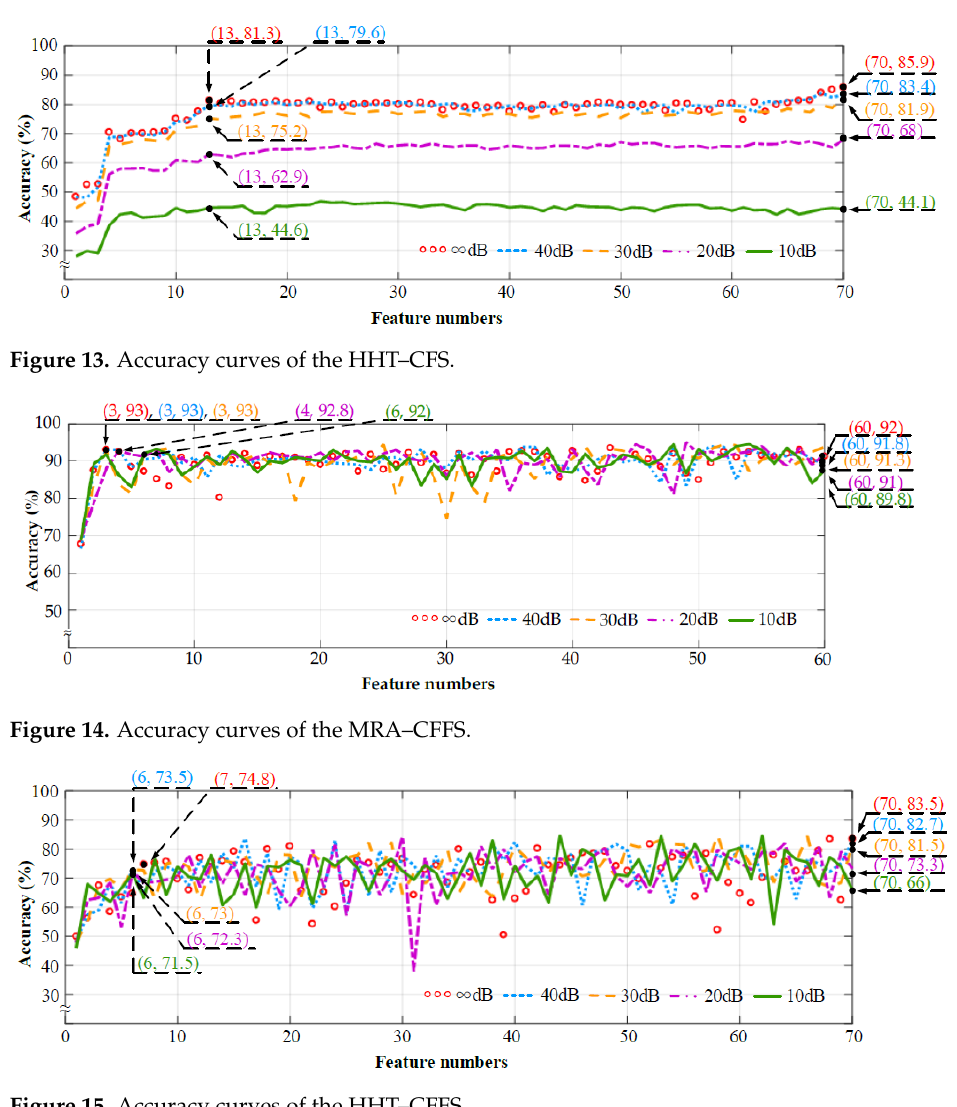
Figure 12. Accuracy curves of the MRA–CFS.